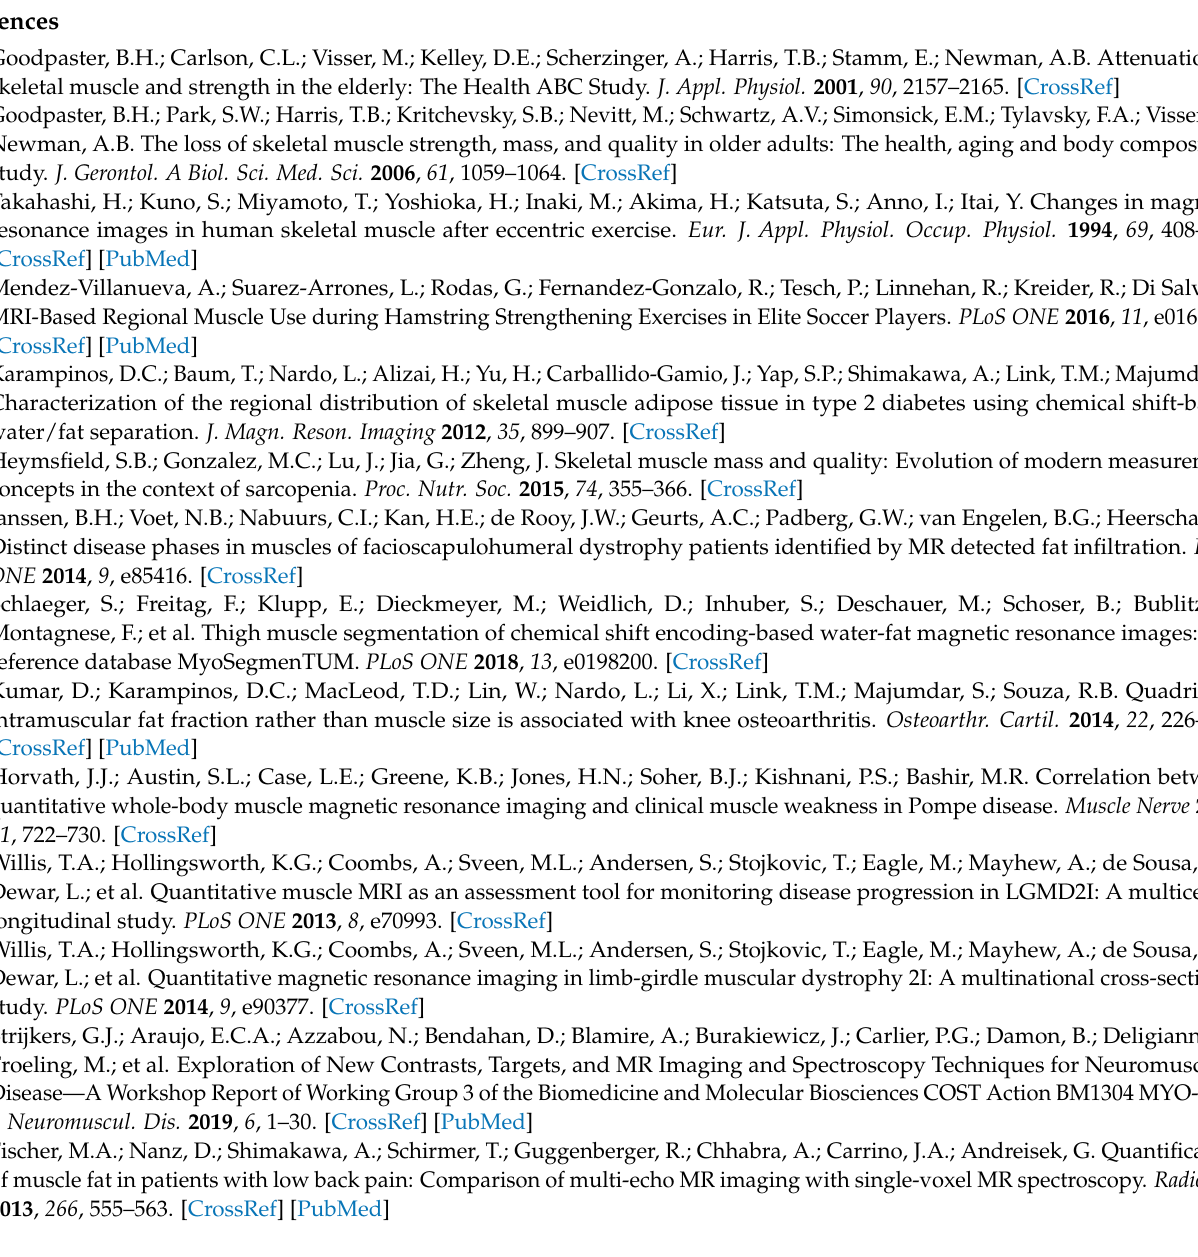
Texture features of the quadriceps muscle are abbreviated using the subscript ‘EXT’ , e.g., Correlation EXT . Texture features of the ischiocrural muscles are abbreviated using the subscript ‘FLEX’ , e.g., Correlation FLEX